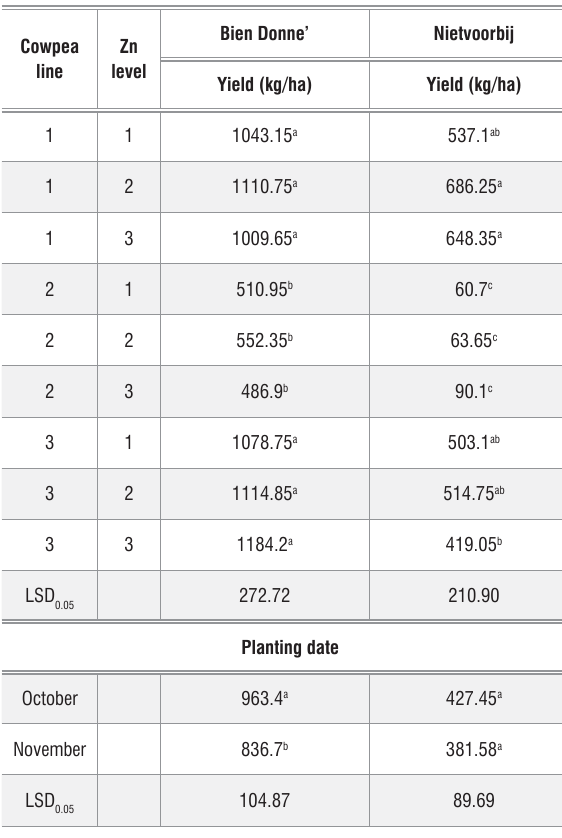
Average seed yield (kg/ha) across the two locations